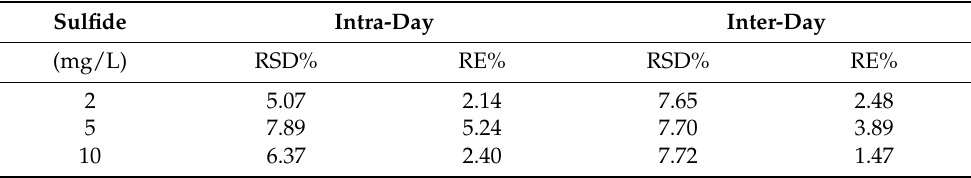
Table 2. Assessment of intra- and inter-day accuracy and precision, measured by relative standard deviation RSD%, and relative error RE%.